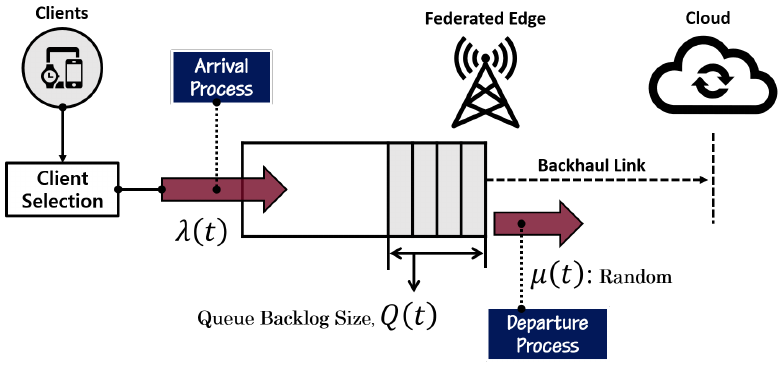
Figure 5. Queue model of data queue in federated edge